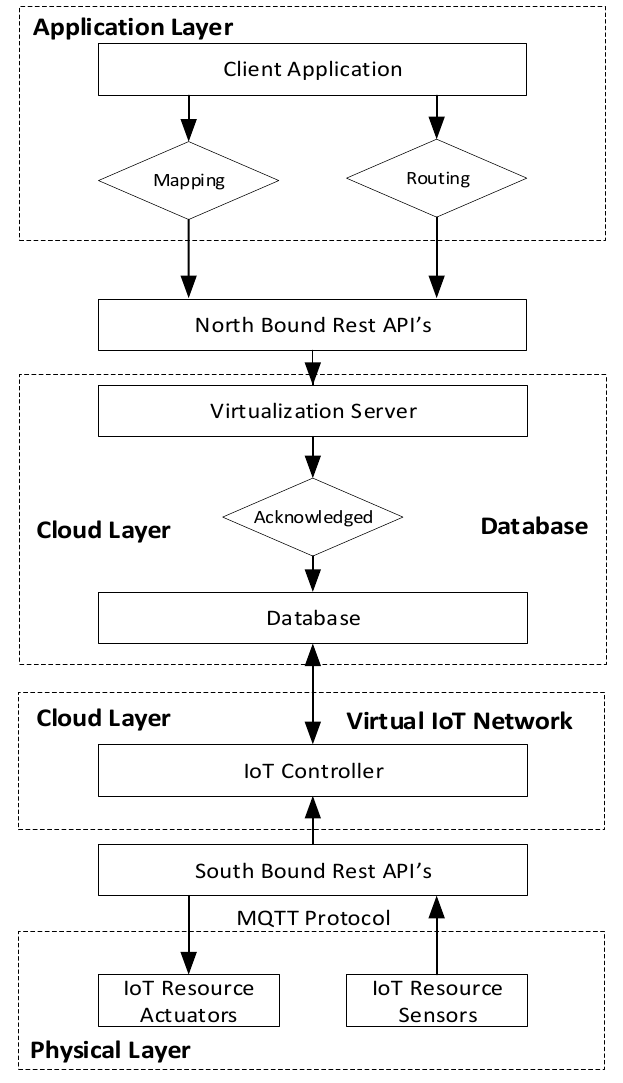
Figure 4. Layered Architecture of the Virtual IoT